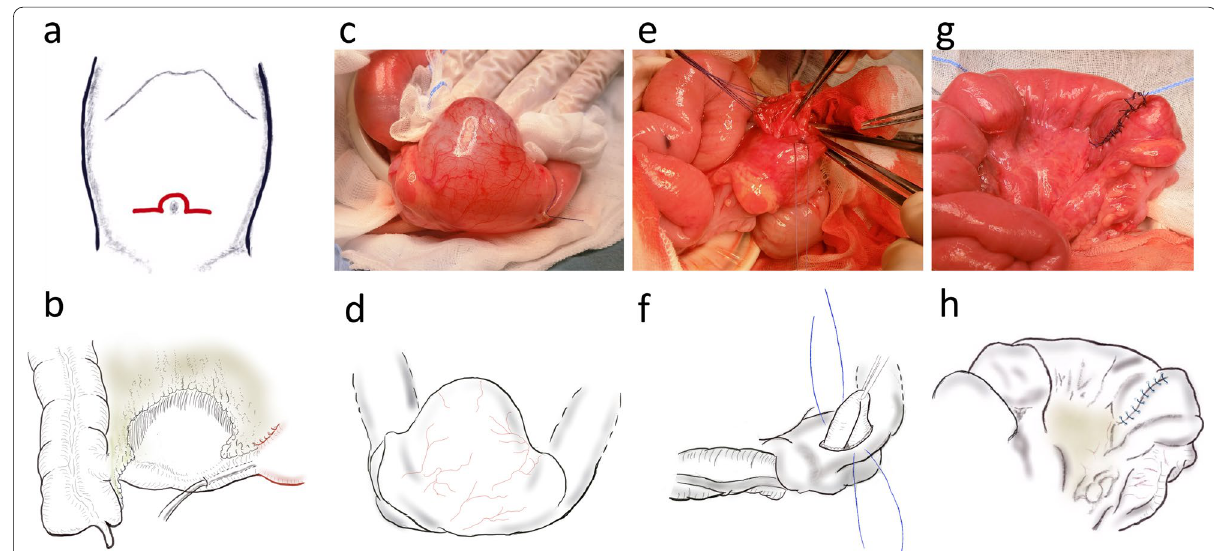
Fig. 2 Operative findings and illustration of cyst resection in Case 1. a Omega-shaped incision of the umbilicus (length: 9 mm) was made. b Schematic showing the location of the duplication cyst. c , d Cyst was on the mesenteric side at the ileocecal junction. e , f Mucosa of the cyst was dissected from the muscular layer. g , h Seromuscular defect was closed in a transverse fashion and the mesentery was